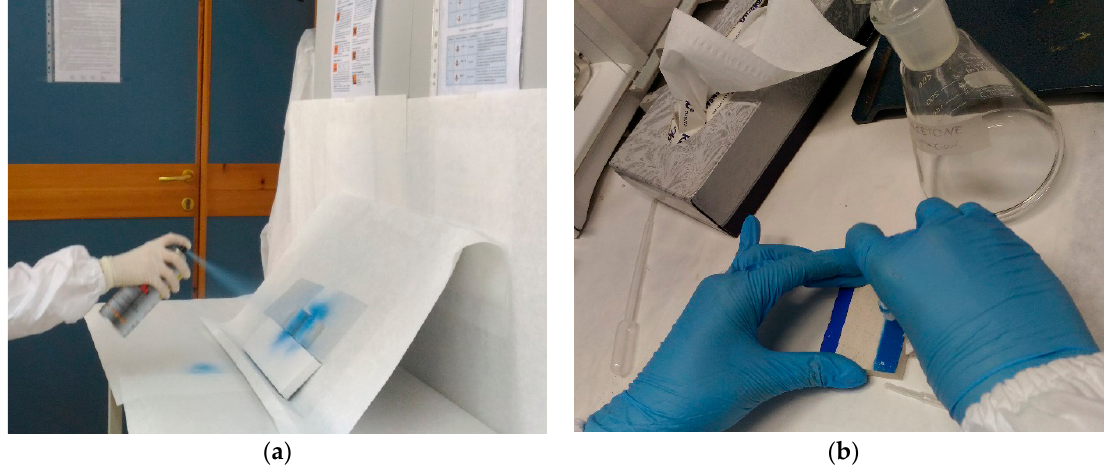
Figure 4. Staining by spray paint ( a ) and removal with acetone ( b ).